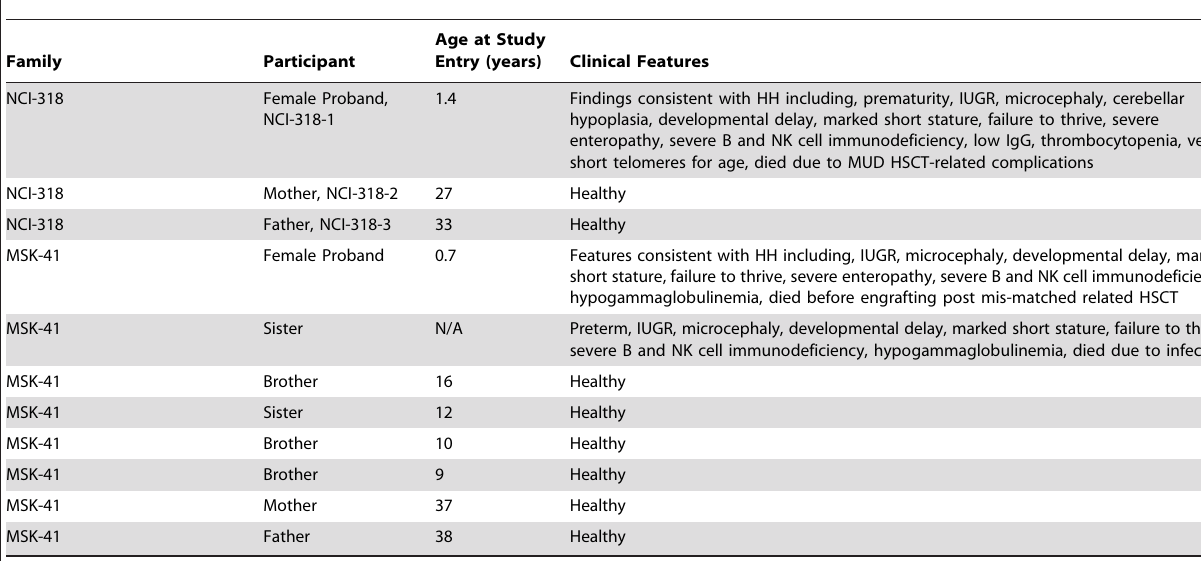
Table 1. Clinical characteristics of families with RTEL1